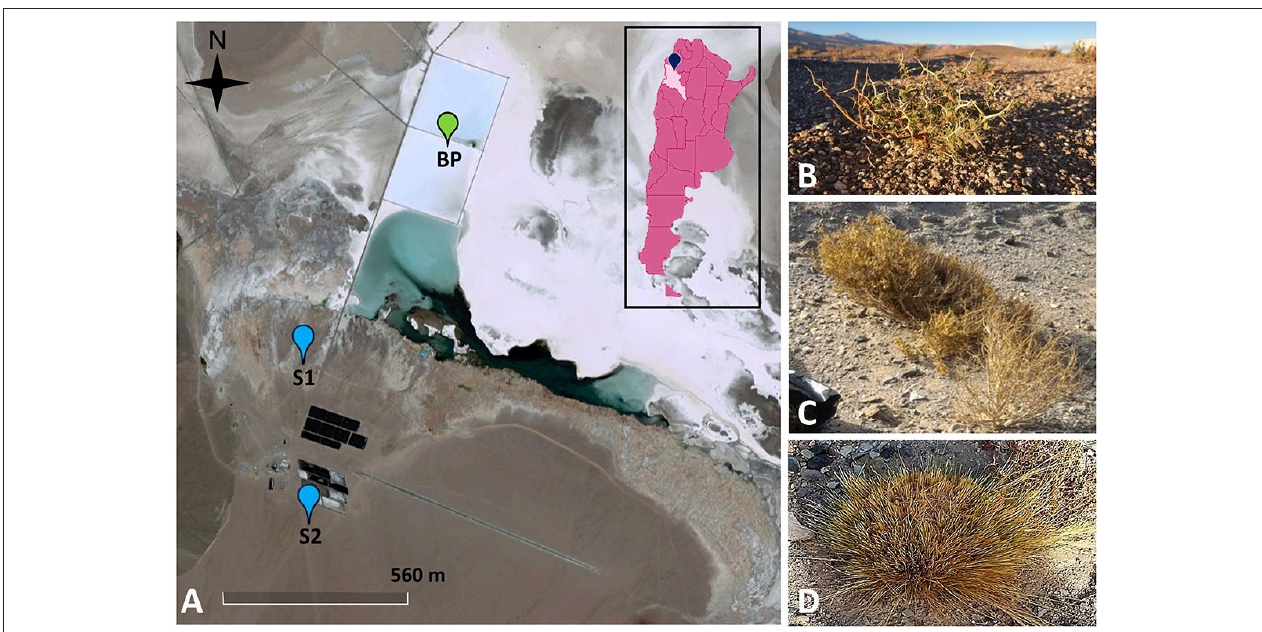
FIGURE 1 | Sampling points located in a lithium mining deposit in operation in the salt flat Salar del Hombre Muerto, Catamarca Province, Argentina (A) . Site one (S1) (25 ◦ 28 ′ 49.38 ′′ S, 67 ◦ 6 ′ 22.74 ′′ W), Site two (S2) (25 ◦ 29 ′ 4.62 ′′ S, 67 ◦ 6 ′ 19.5 ′′ W), lithium brine concentration pools (BP). Samples were collected from soil and roots of native vegetation from the families Fabaceae (B) and Asteraceae (C) , located in S1, and Poaceae (D) , located in